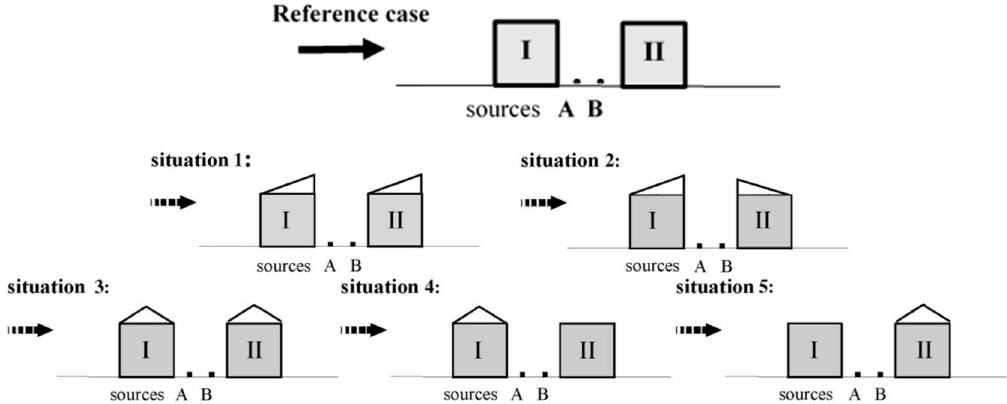
Figure 22. Schematic diagrams of the street canyon arrangement.